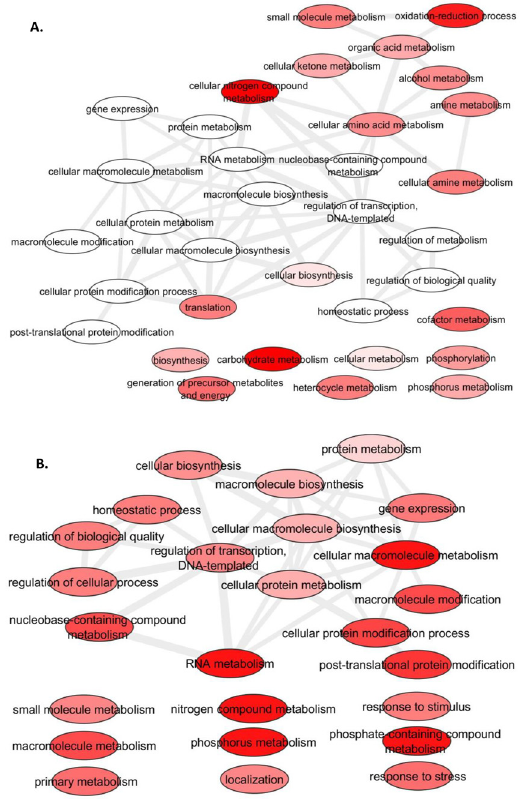
Fig 3. Visualization of GO terms in biological functions of module 13 and 36. Significance (FDR p-values) of GO term is color labeled from red to white. Similar GO terms are linked by edges, where the degree of similarity represented by the line width. (A) Module 13, (B) Module